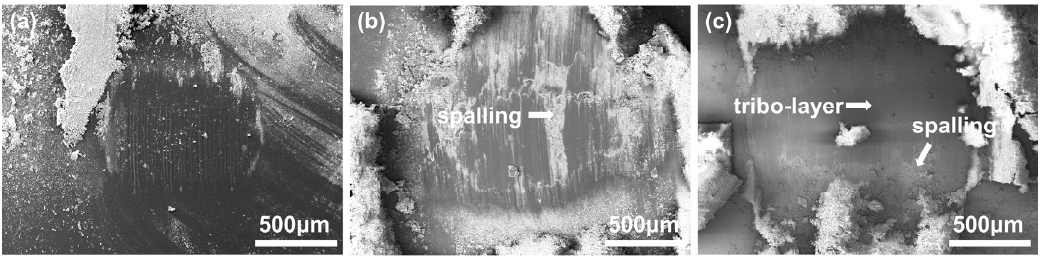
Figure 8. SEM of the Al 2 O 3 counter ball, mating with N self-lubricating composite: ( a ) RT, ( b ) 400 °C, and ( c ) 800 °C.